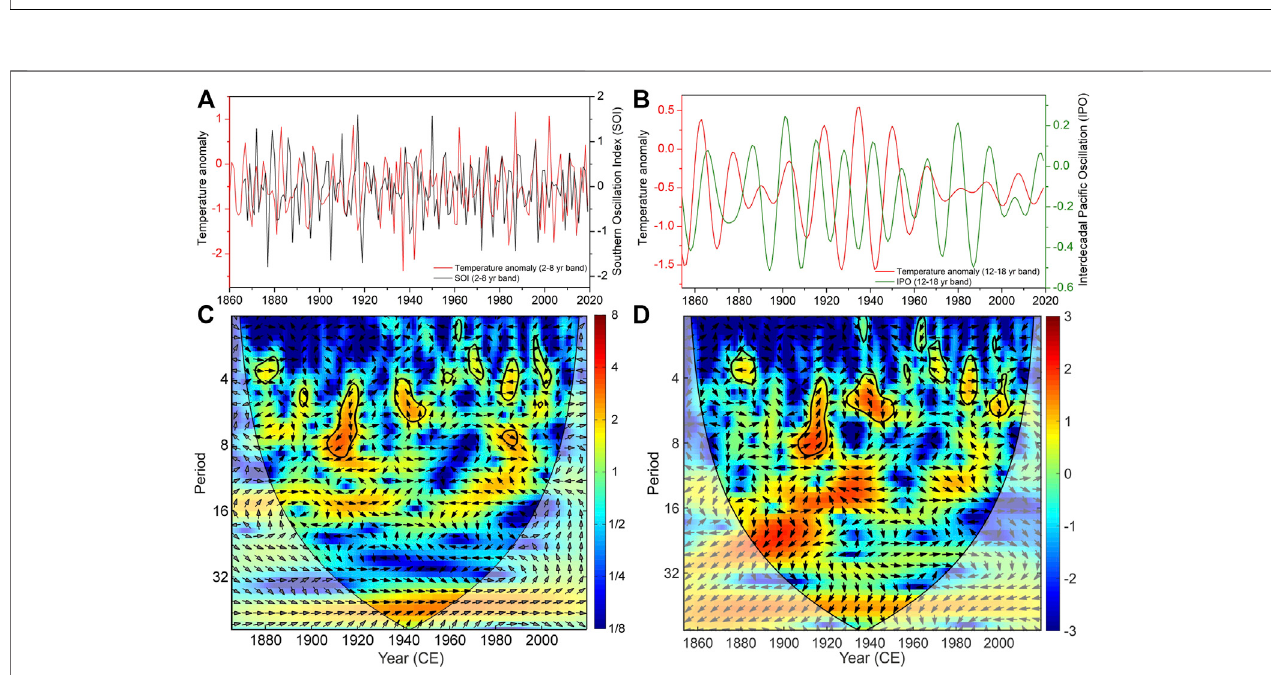
FIGURE6| Annualvariabilityintemperatureanomalyrecordwith (A) SOI(1866 – 2019CE)(RopelewskiandJones,1987)and (B) IPO(1854 – 2019CE)(Mantuaand Hare, 2002). Cross-wavelet analysis of DML temperature anomaly with (C) SOI and (D) IPO. The thick black line depicts the cone of in fl uence. The relative phase relationship is shown as arrows (with in-phase pointing right, antiphase pointing left, temperature leading SOI or PDO by 90 ° pointing straight down, and vice versa).